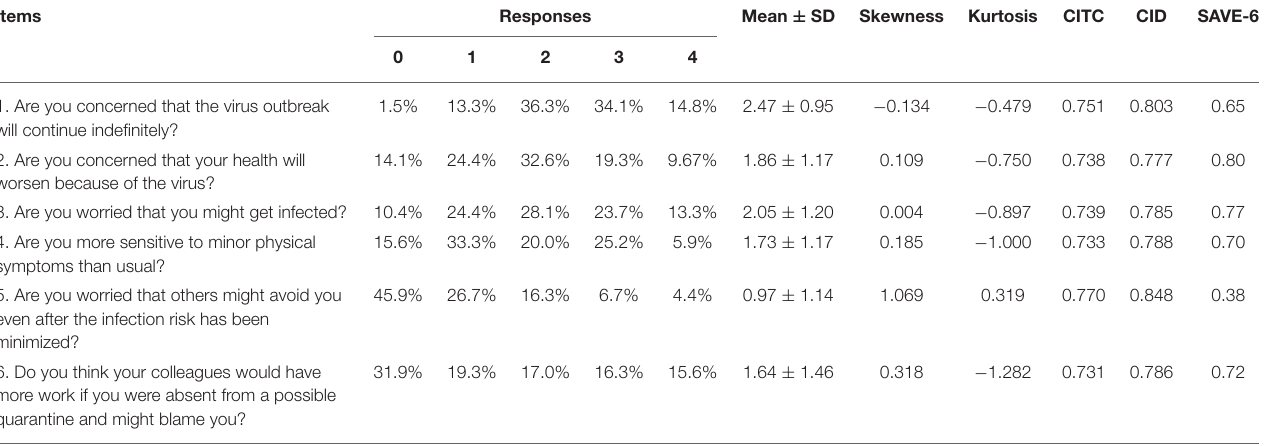
TABLE 2 | Factor structure of the SAVE-6 scale and factor